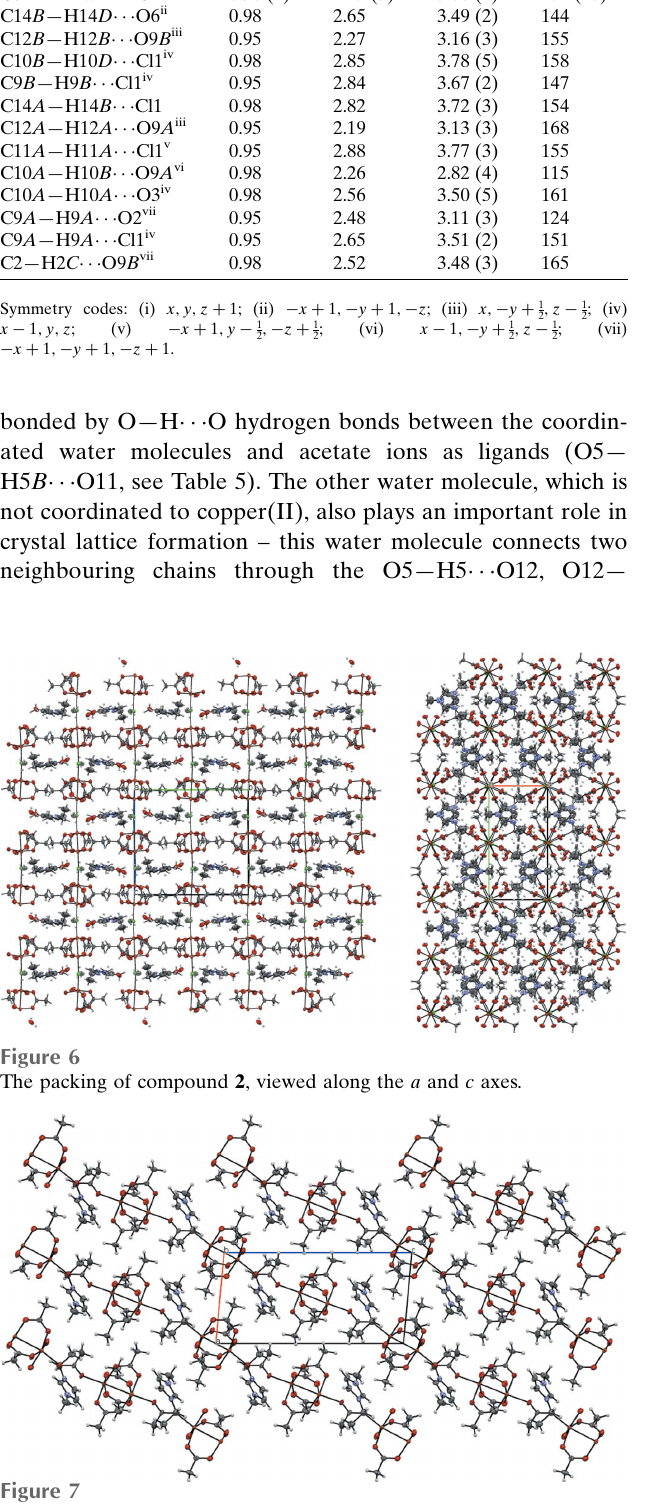
Figure 8 The packing of compound 4 , viewed along the b